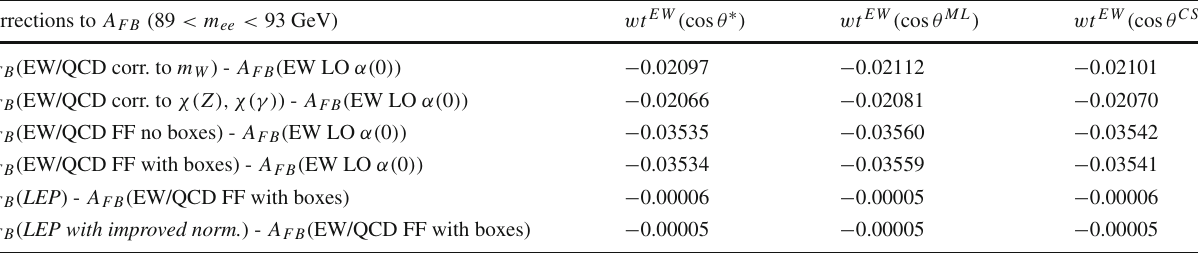
Table 6 The difference (cid:8) A FB in forward–backward asymmetry around Z -pole, m ee = 89–93 GeV. The cos θ CS is used to define forward and backward hemispheres. The EW weight is calculated respectively from cos θ ∗ , cos θ Mustraal or cos CS Corrections to A FB (89 < m ee < 93 GeV) w t EW ( cos θ ∗